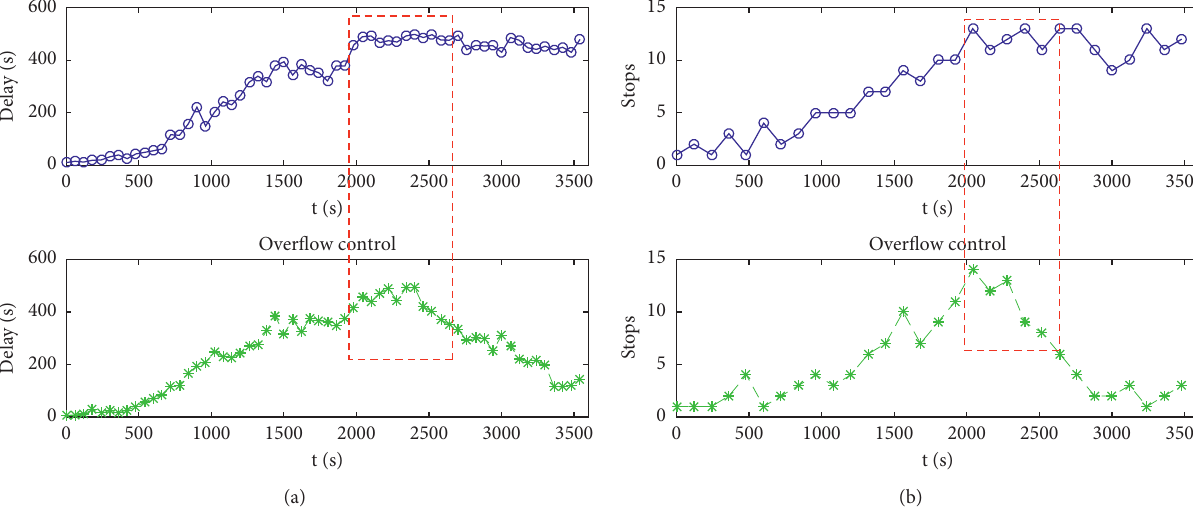
Figure 10: Analysis of overflow control at the intersection of Siping Road and Shengli Street in Weifang. (a) Total delay time at the intersection. (b) Cycle average of stops at the